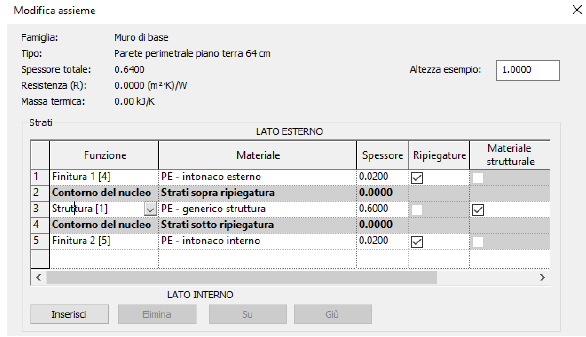
Figure 3. Example of wall definition in Revit.